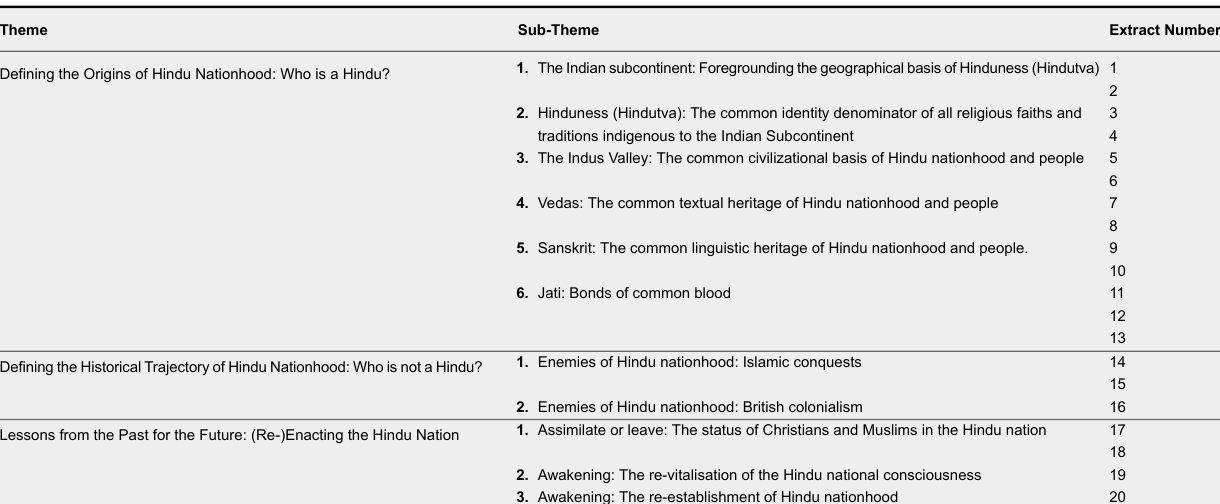
Lessons from the Past for the Future: (Re-)Enacting the Hindu